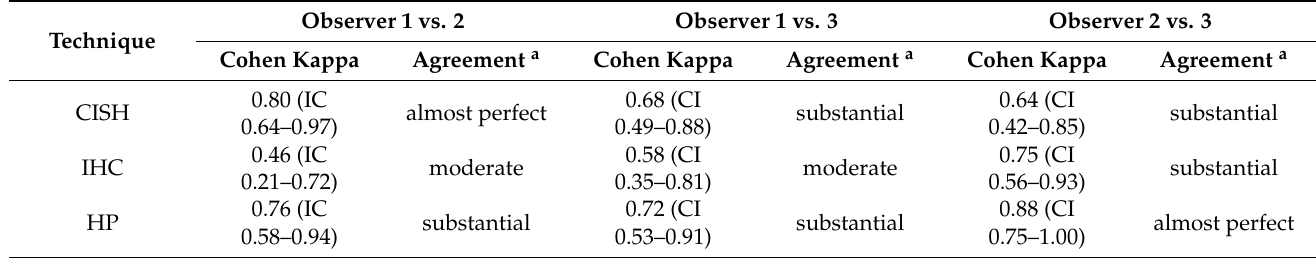
Table 6. Inter-observer agreement for the IHC, CISH, and HP techniques for the detection of amastig- otes in skin samples fixed in 10% formalin and paraffin-embedded from patients with new world cutaneous leishmaniasis caused by L. ( V. ) braziliensis